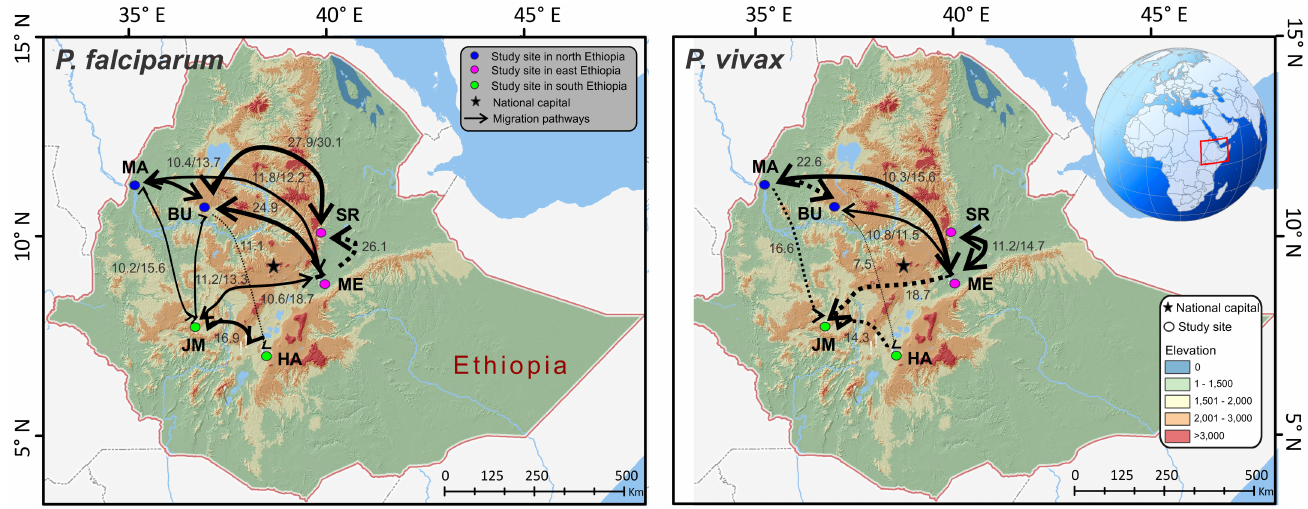
Fig 4. Migratory pathways and rates of Plasmodium falciparum and P . vivax among the study sites in Ethiopia. The intensity of gene flow is indicatedby the thickness of migration paths. Solid lines denote bi-directional migrationand dotted lines denoteuni-directional migration. Only migration rate ( M : immigration rate scaled by mutation rate) with a value of (cid:21) 10 are indicatedon the maps. All values are presented in S6 Table.